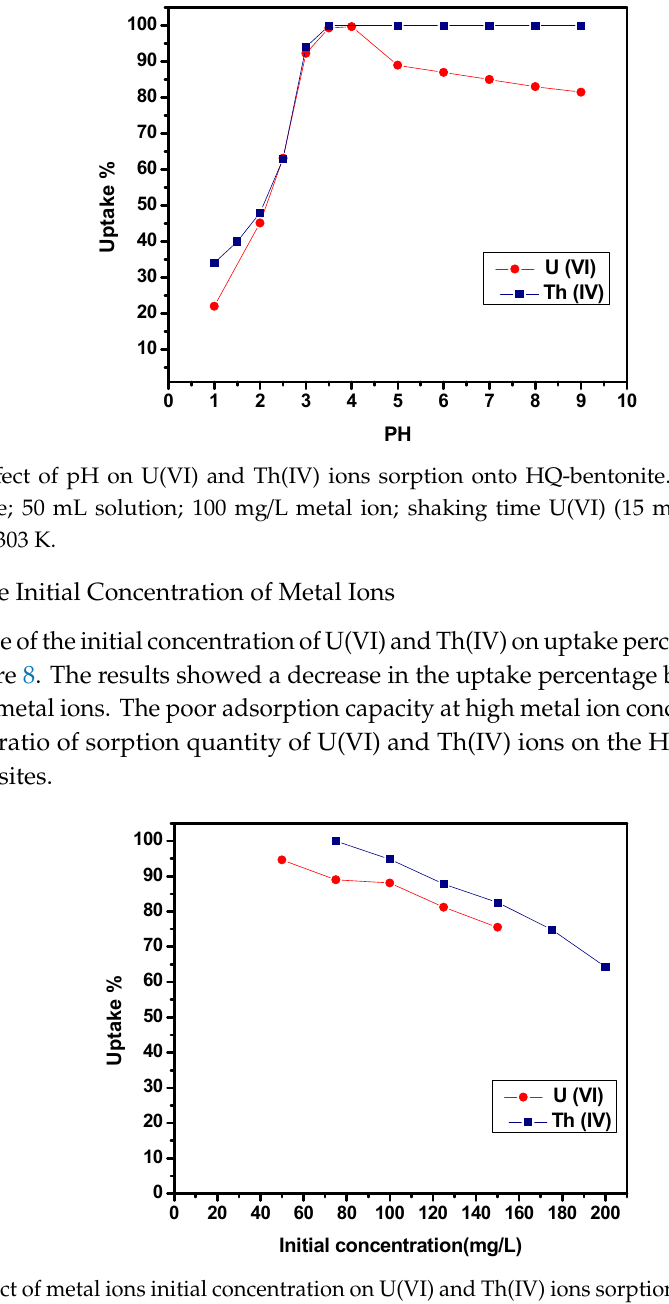
Figure 8. E ff ect of metal ions initial concentration on U(VI) and Th(IV) ions sorption onto HQ-bentonite. Conditions: 0.1 g HQ-bentonite; 50 mL solution; U(VI) (pH 4), Th(IV) (pH 3); shaking time U(VI) (15 min.), Th(IV) (8 min.); temperature 303 K.